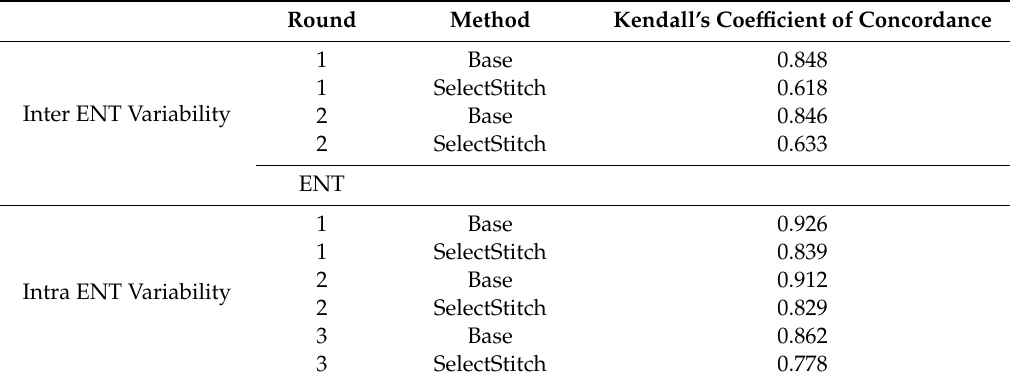
Table 4. Inter- and Intra-ENT